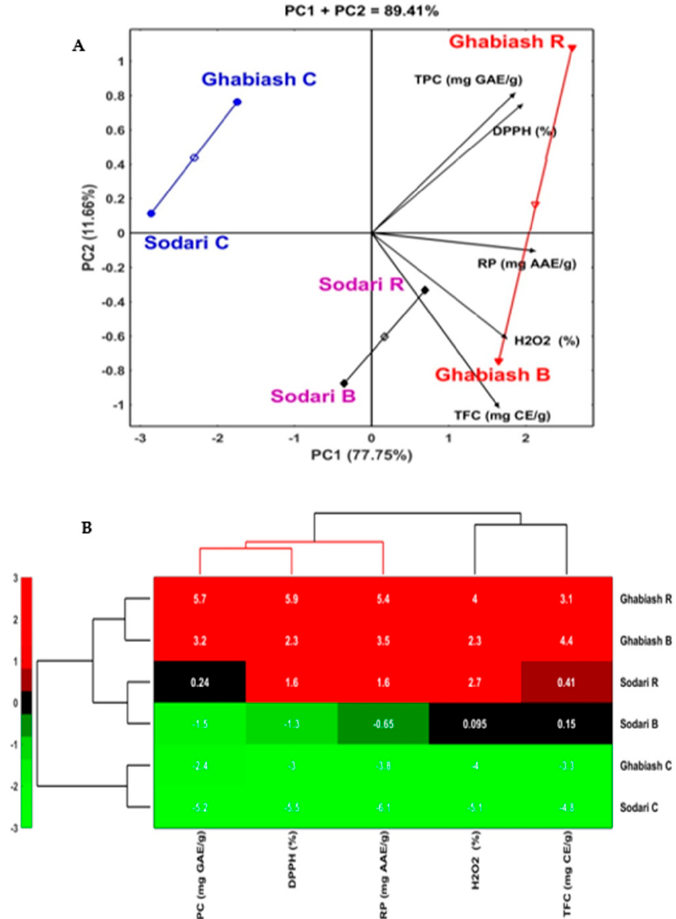
Figure 6. HJ-biplot based on the principal component analysis ( A ) and heatmap ( B ) of peanut shells of Sodari and Ghabiash cultivars as affected by roasting and boiling treatments.